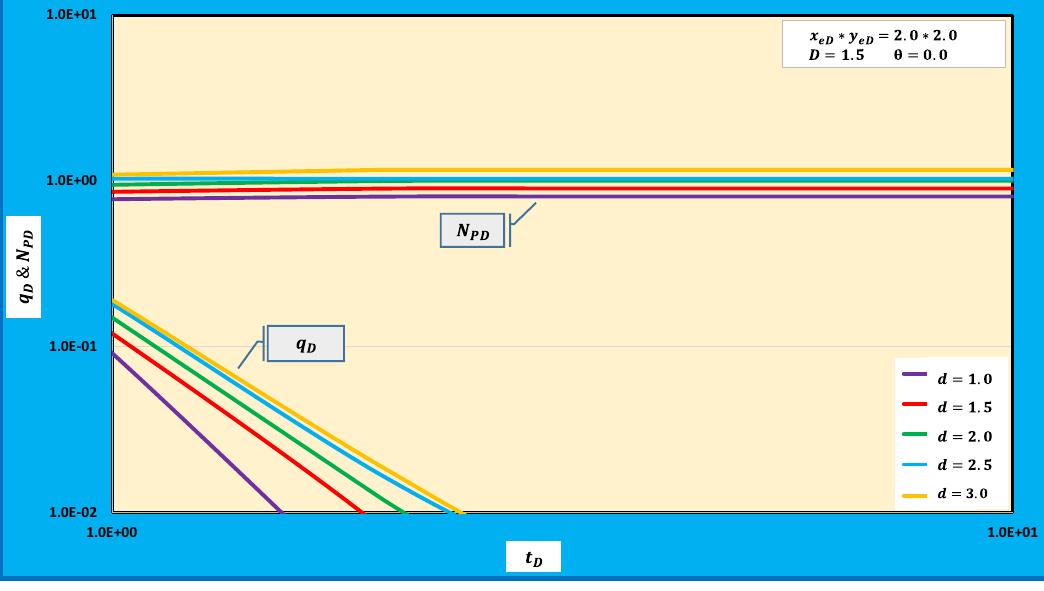
Fig. 27 Flow rate and cumulative production behaviors during pseudo-steady state flow regime for different fractal